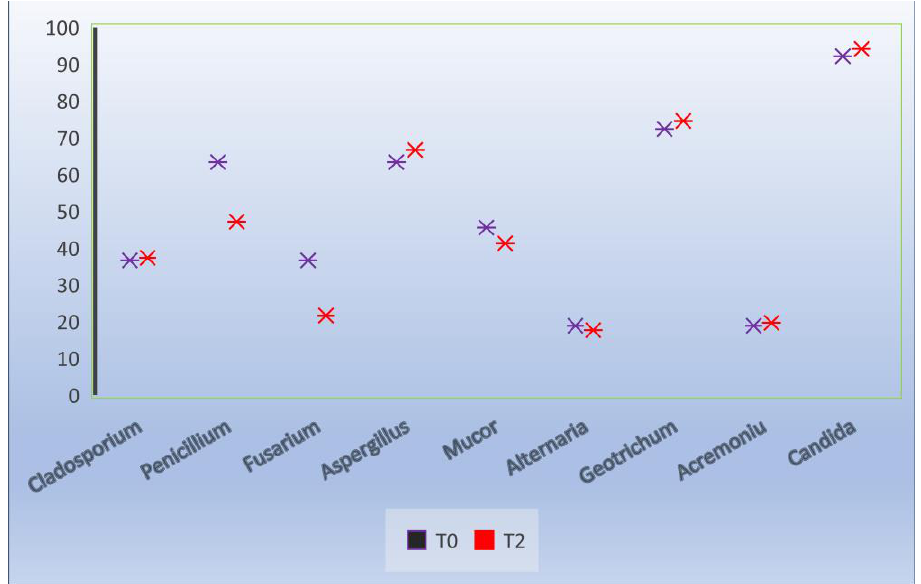
Figure 3. Effect of extenders on the frequency of bacterial isolation, T0 at the time of collection, T2 24 h after dilution.